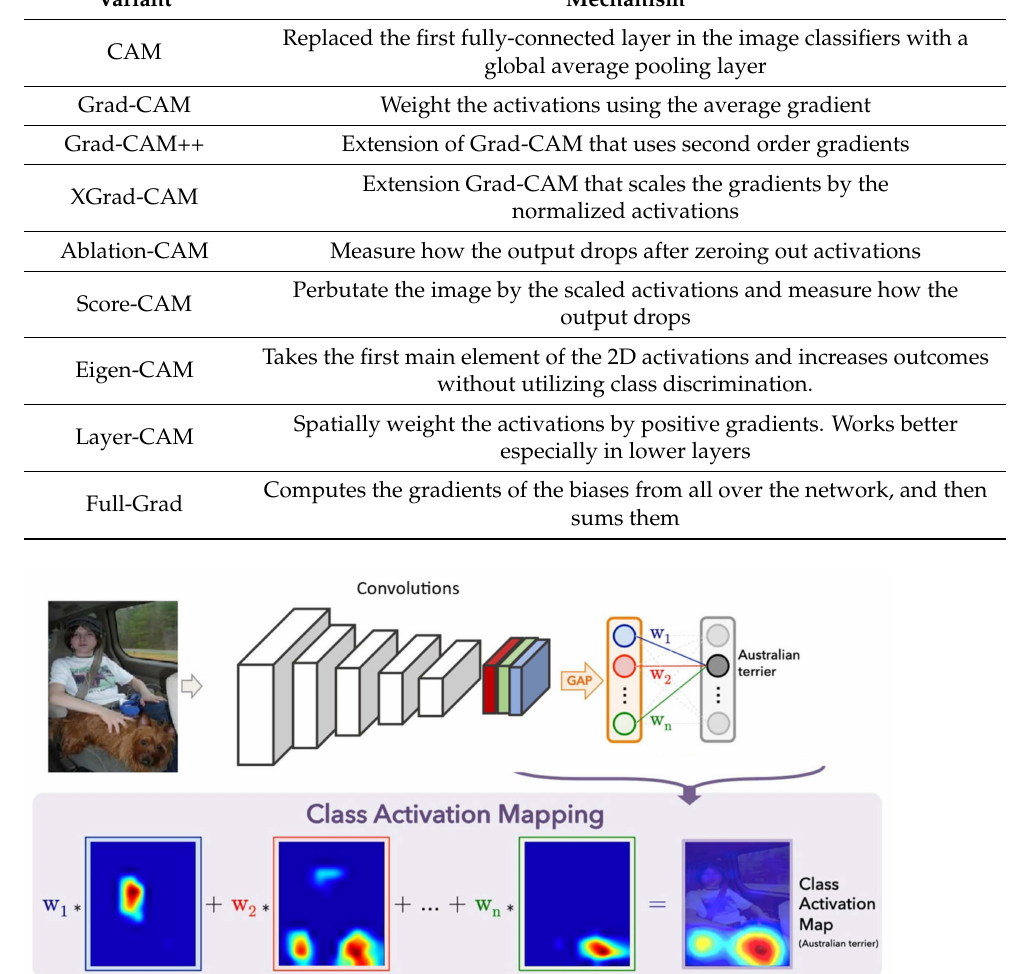
Figure 10. Highlighting class-wise discriminative regions using Class Activation